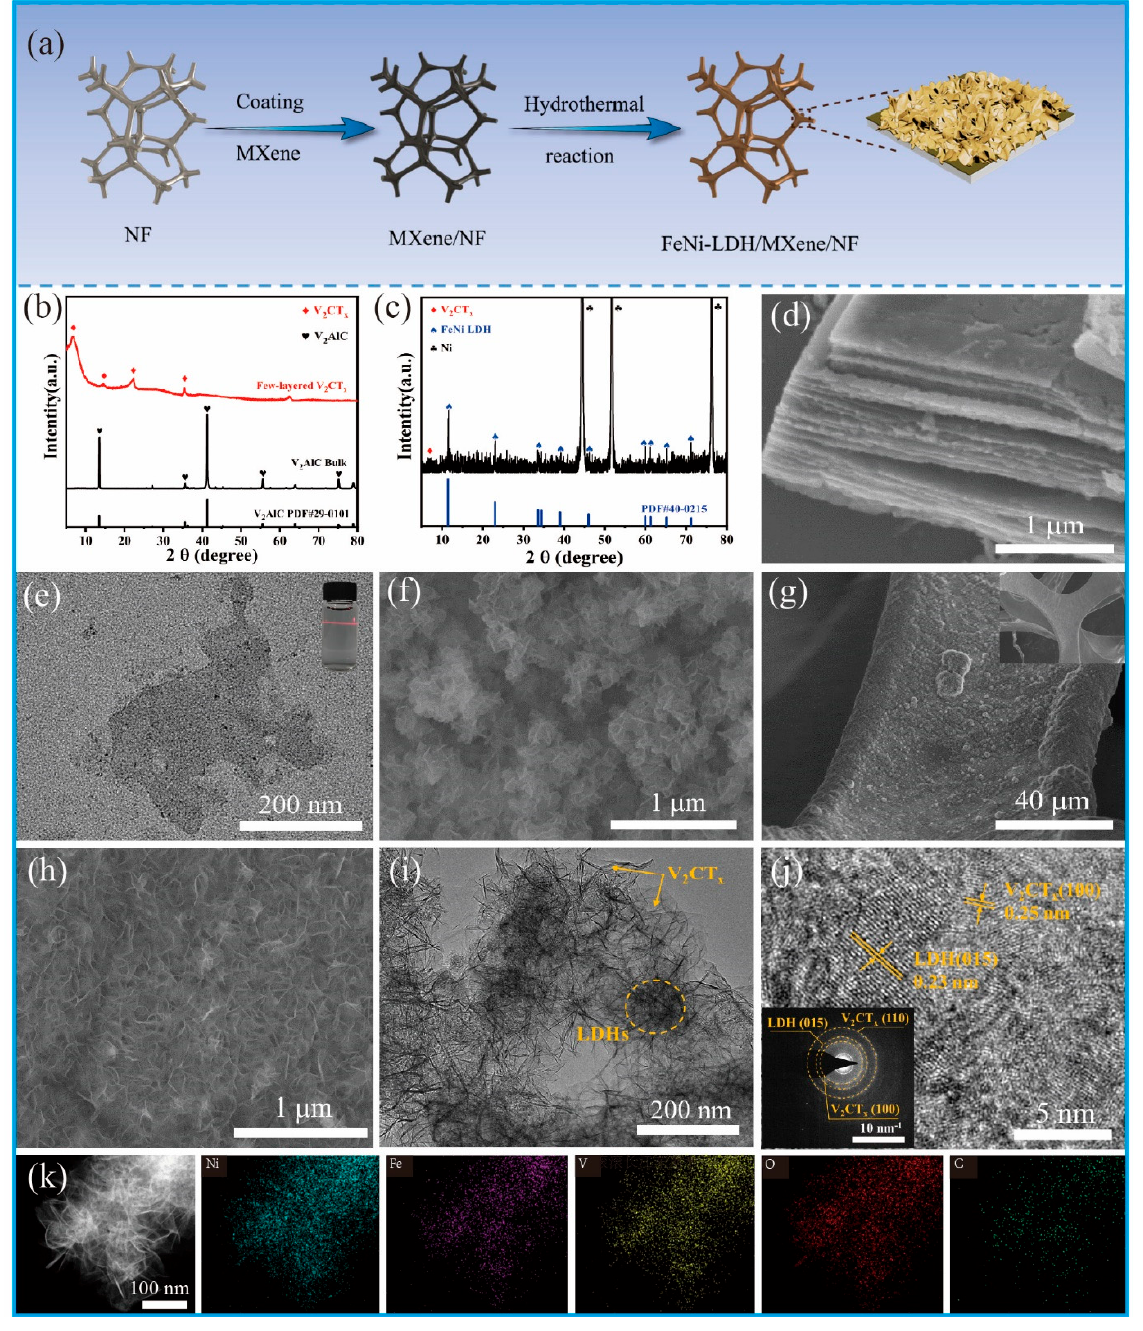
Figure 1. ( a ) Synthetic route of FeNi LDH/V 2 CT x /NF. SEM images of multilayered V 2 CT x ( b ) XRD of V 2 AlC and V 2 CT x . ( c ) XRD patterns of FeNi LDH/V 2 CT x peeled off the nickel foam. ( d ) with TEM images of few-layer V 2 CT x ( e ), FeNi LDH/NF sample ( f ) and FeNi LDH/V 2 CT x /NF sample ( g , h ). TEM images of FeNi LDH/V 2 CT x nanohybrids peeled from NF ( i ), HRTEM images of FeNi LDH/V 2 CT x nanohybrids ( j ), the HAADF-STEM images in ( k ). The XPS spectra of the FeNi LDH/V 2 CT x /NF sample showed Fe, Ni, V, O and C signal peaks (Figure 2a). Since V 2 CT x /NF is covered by NiFe LDH, the signal peak of V is very weak. The high-resolution O 1s XPS spectra (Figure S8) were deconvolution at about 532.98 eV, 531.78 eV and 530.84 eV to obtain three component peaks corresponding to H-O-H, M-OH and M-O, respectively. In the Ni 2p XPS spectrum (Figure 2b), the two characteristic peaks of 2p 1/2 and 2p 3/2 orbits of Ni 2+ are located at 874.38 eV and 856.59 eV, respectively [45]. Similarly, in Fe 2p spectra (Figure 2c), peaks at 725.98 eV and 712.75 eV